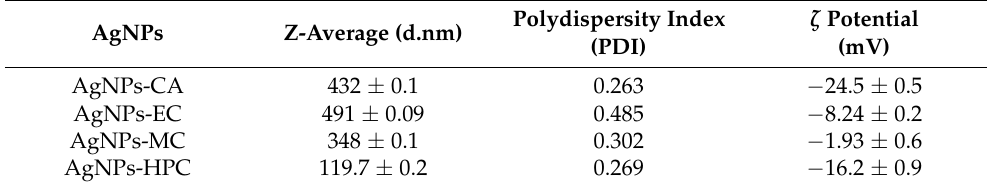
Table 1. Average size values determined by DLS, polydispersity indices, and ζ potential values of the AgNPs synthesized from cellulose